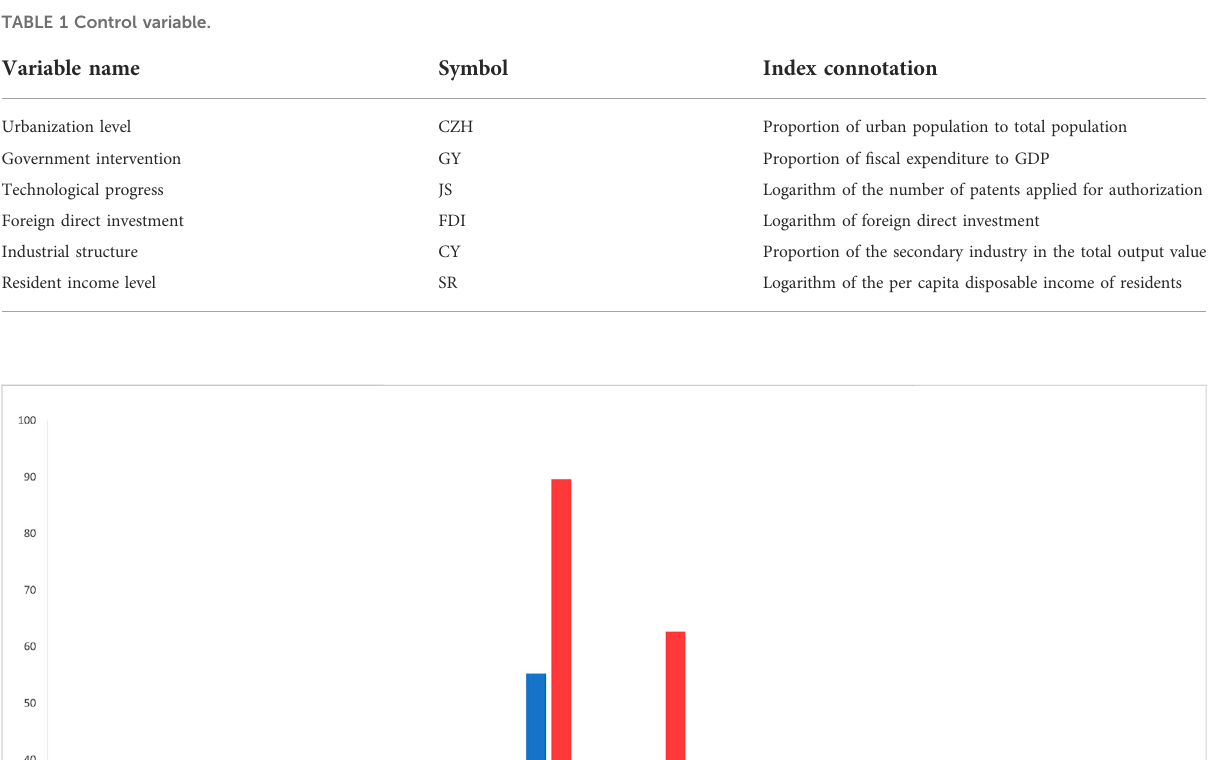
TABLE 1 Control variable.